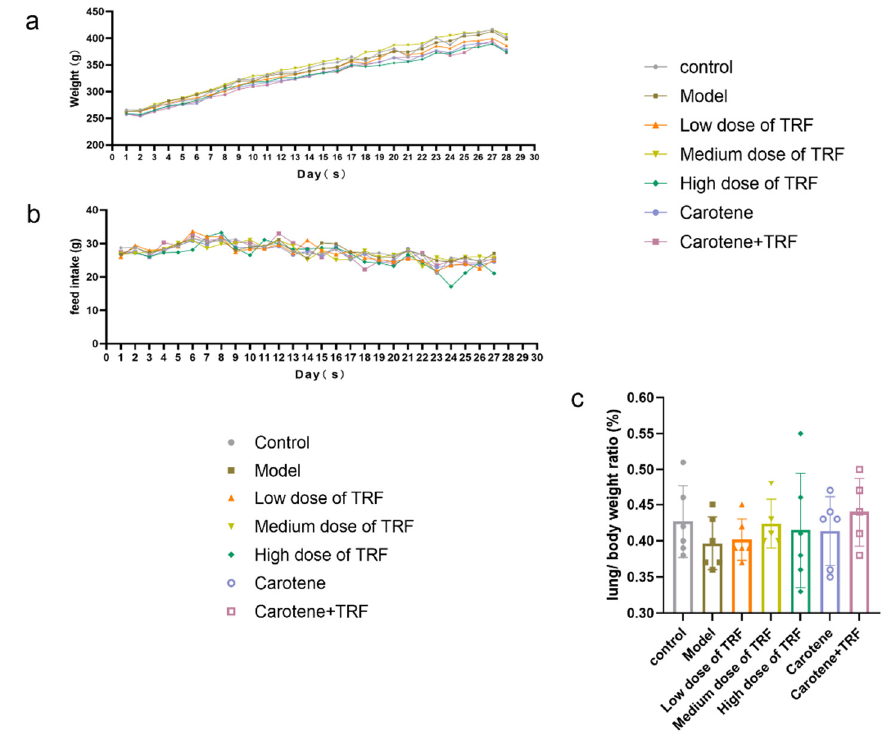
Figure 1. Effects of TRF and carotene on weight (g), feed intake (g) and lung/body weight ratio (%): ( a ) Body weight changes in rat groups recorded every other day after BLM administration; ( b ) feed intake changes in rat groups recorded every other day after BLM administration; ( c ) lung/body weight ratios in rat groups on final day. Data are expressed as the mean ± SD; n = 6. There was no significant difference between the groups.